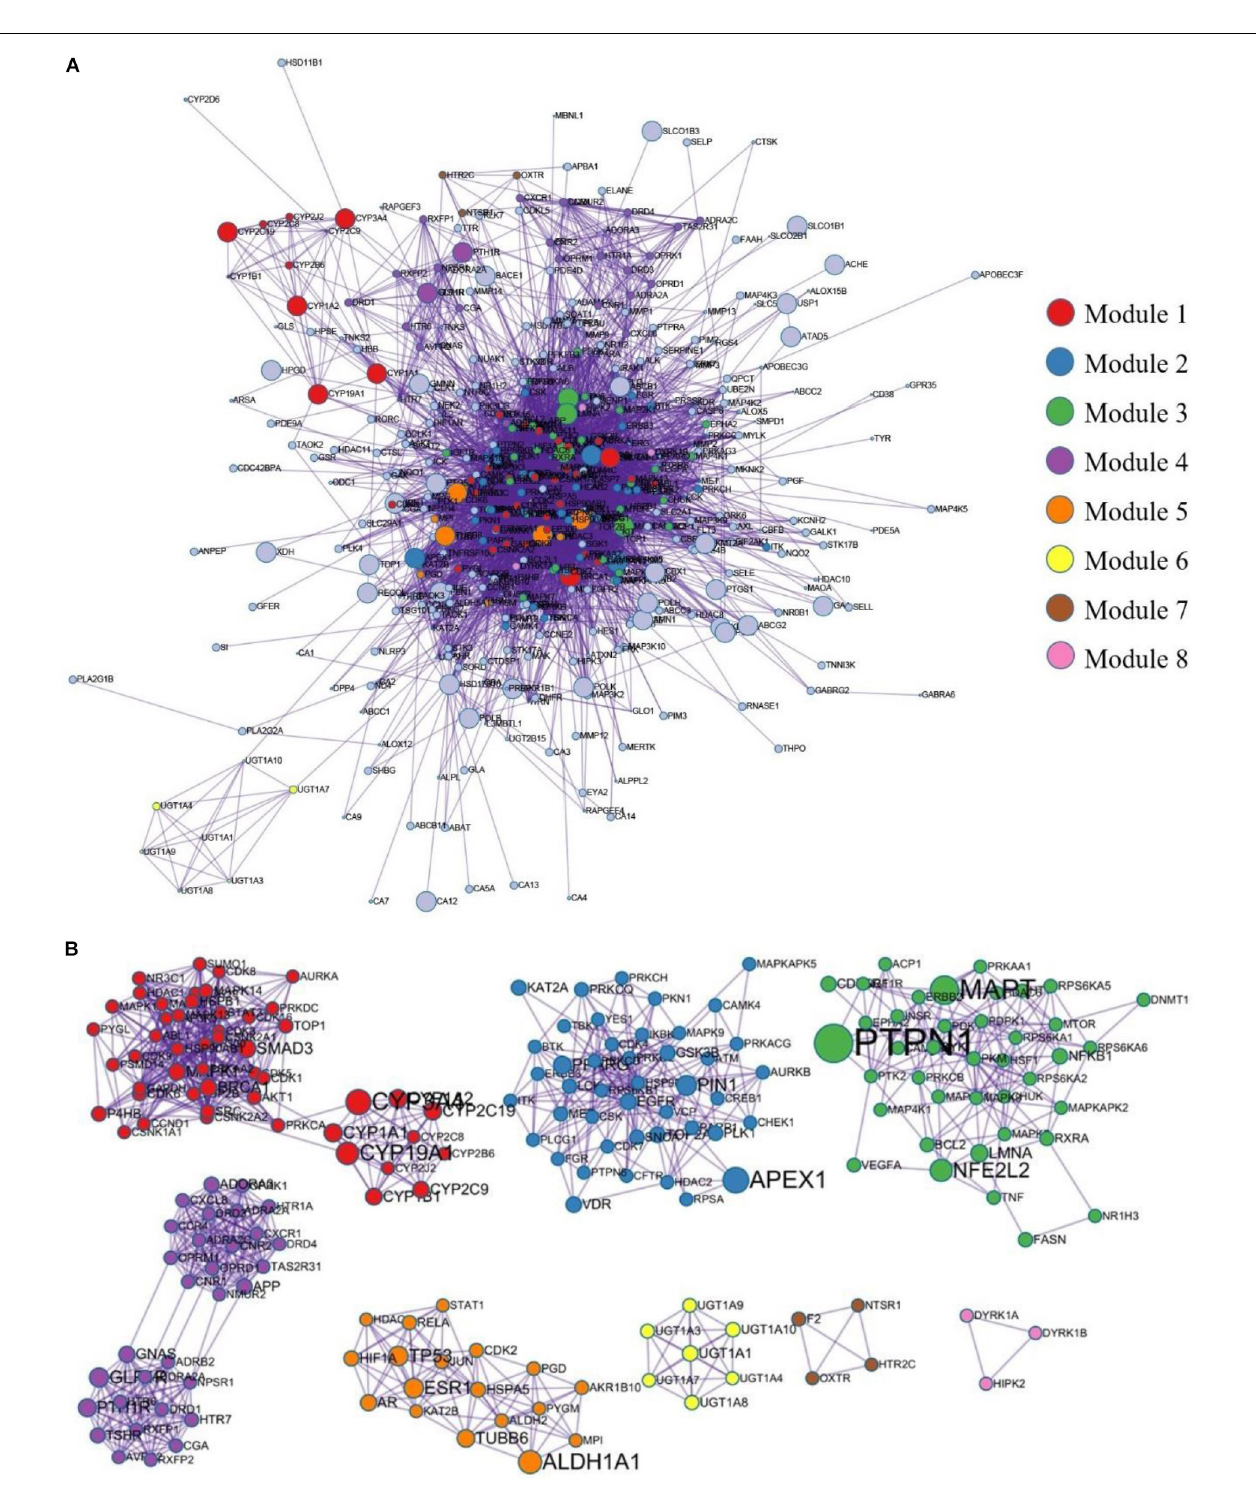
FIGURE 4 | Protein–protein interaction (PPI) network of natural flavonoid products’ targets. (A) General PPI network of natural flavonoid products’ targets. (B) Modularized PPI network of natural flavonoid products’ targets. Size of each node represents the ratio (=number of target related compounds/total number of compounds) of targets. Different modules were marked in different